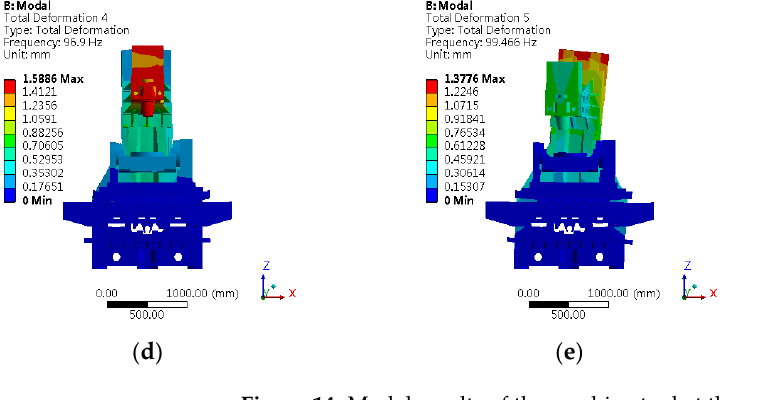
Figure 14. Modal results of the machine tool at the coordinate origin x = 0 mm, z = 0 mm, y = 0 mm, θ = 0°; ( a ) First mode; ( b ) Second mode; ( c ) Third mode; ( d ) Fourth mode; ( e ) Fifth mode; ( f ) Sixth mode. Table 6. First six-order natural frequencies of a two-axis rotary table five-axis machine tool.